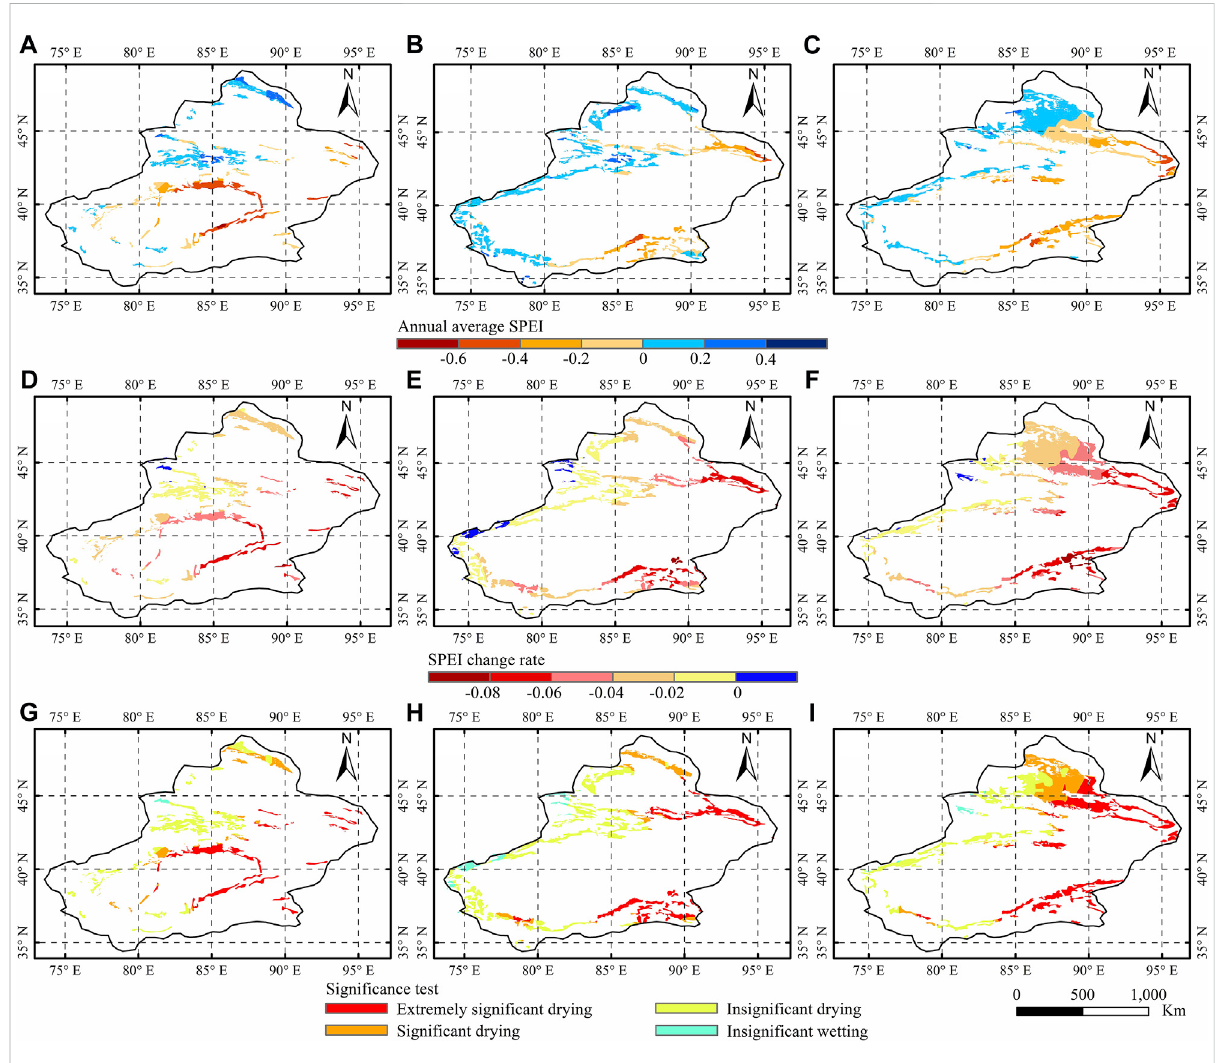
FIGURE 5 Spatial distribution pattern of the annual average SPEI-12 and change rate and signi fi cance test of meadow, steppe, and desert grassland in Xinjiang.[TheannualaverageSPEIofmeadow (A) ,steppe (B) ,anddesertgrassland (C) inXinjiang;theSPEIchangerateofmeadow (D) ,steppe (E) ,and desert grassland (F) in Xinjiang; and the signi fi cance test of meadow (G) , steppe (H) , and desert grassland (I) in